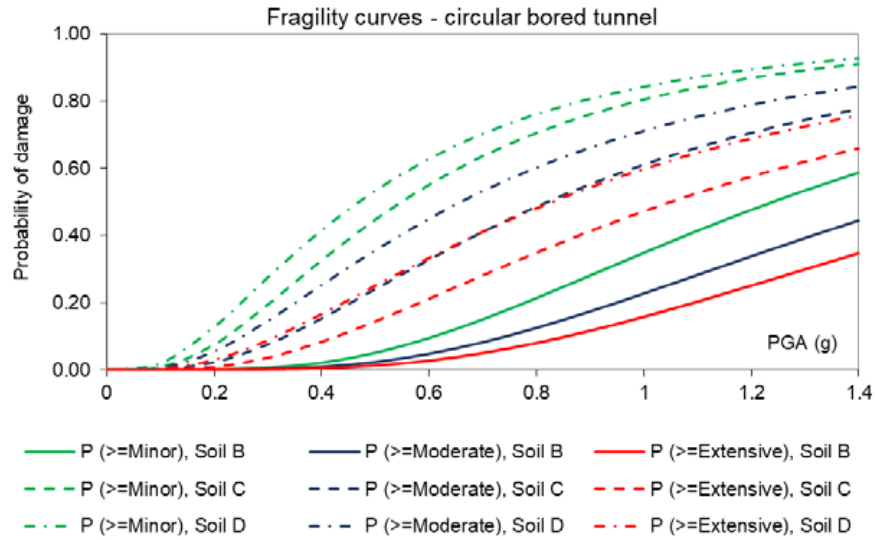
Figure 4. Analytical fragility curves developed by Argyroudis and Pitilakis [52] for a circular tunnel in alluvial for various damage states, assuming various soil classes for surrounding ground.